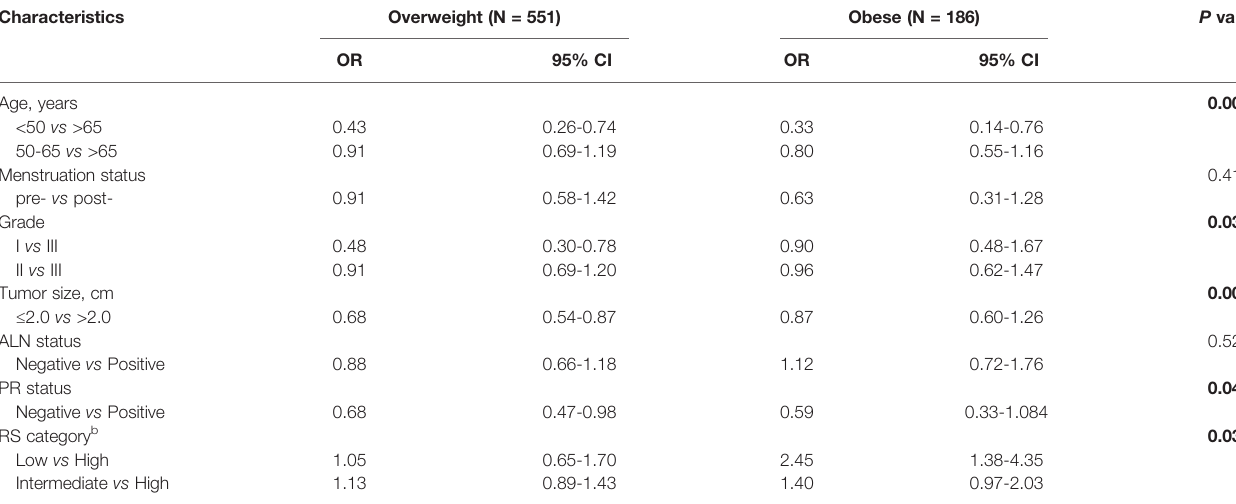
TABLE 2 | Multivariate analysis of factors associated with BMI status. a